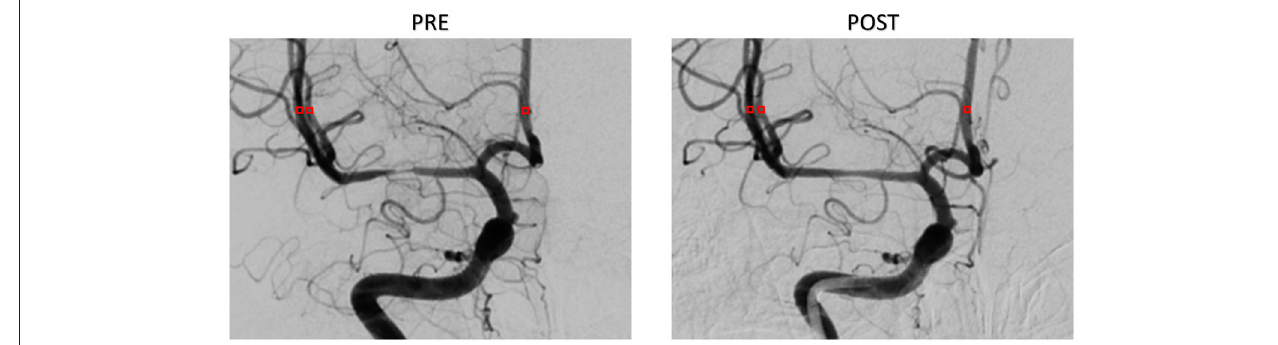
FIGURE 4 | Region of interest location selection on DSA images.